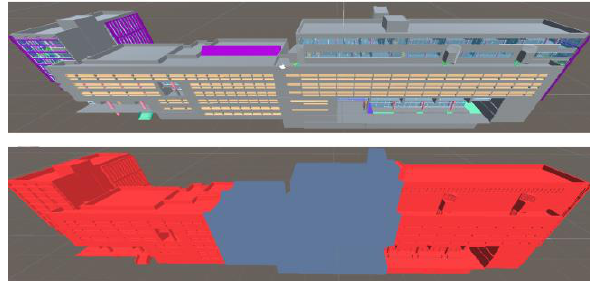
Figure 2 . Binary voxelisation of a 3D model using 10 cm size voxels; upper image shows the 3D model in Unity; lower image shows 3 blocks used for voxelisation, where the middle one is highlighted. Figure 4 . Occlusion culling of voxel blocks; upper image shows the rays send from the camera to see which components to turn off; lower image shows the corresponding camera